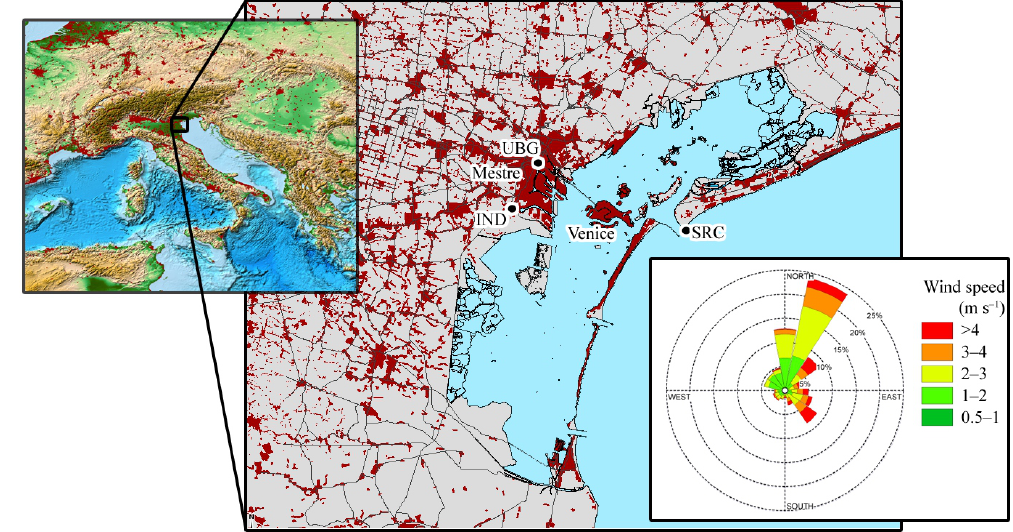
Fig. 1. Study area and wind rose computed for 2009. The main urban settlements are red